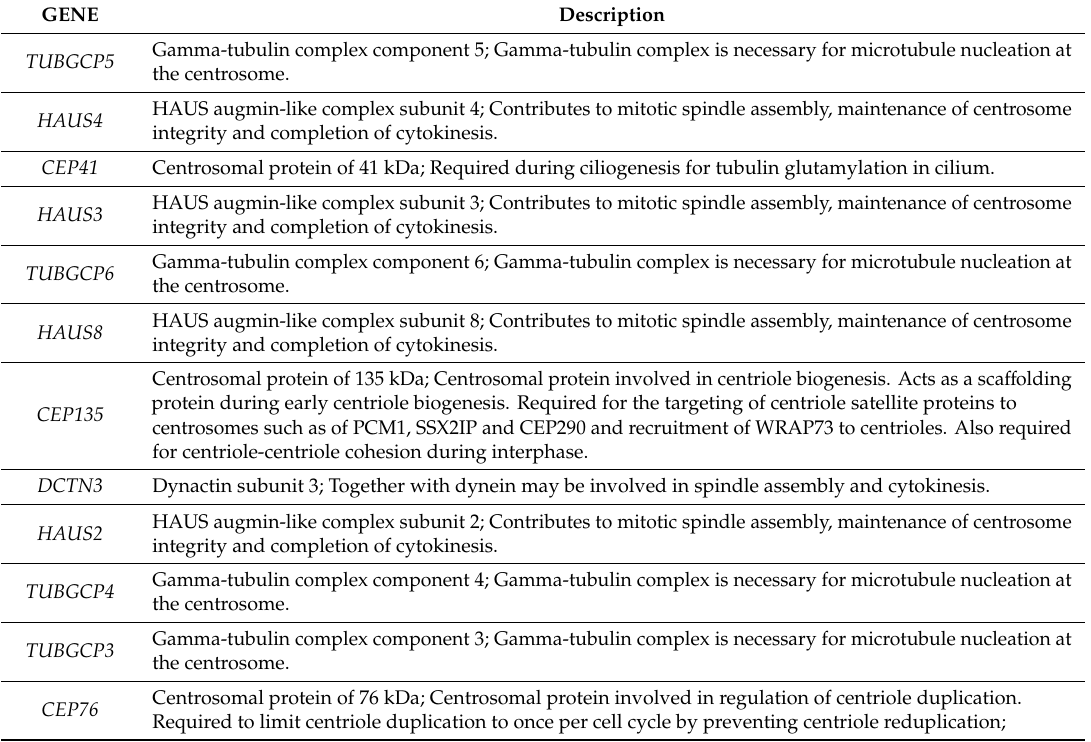
Figure 6. STRING Protein–Protein Interaction Network for TUBGCP5 gene with functional interactions with 26 nodes (Source: STRING.org). Network nodes represent proteins with splice isoforms or post-translational modifications collapsed into each node for all proteins produced by a single protein-coding gene. Edges represent protein-protein associations that are considered specific and meaningful i.e., proteins jointly contribute to a shared function, such as, Biological Process (GO) and Molecular Function (GO) (Table 12). TUBGCP5 gene interactants and their functions are listed in Table 14. (See Figure 2 for legend with a description of symbols and notes on interpreting the interaction of genes and their encoded proteins). Table 14. STRING Interactants and Their Functions for the TUBGCP5 Gene.